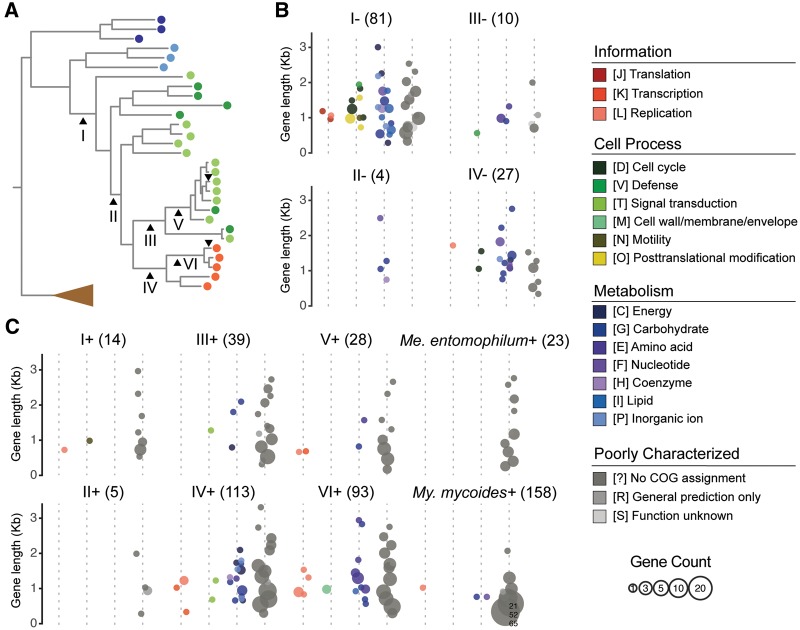
—Characteristics of the genes gained and lost. (A) Phylogenetic positions of the six internal branches and two terminal branches analyzed in this study. The species phylogeny is based on the result from figure 1A. (B) Putative gene losses. The number in parentheses above each subpanel indicates the total number of inferred gene losses. The genes are binned by length using 250-bp intervals and color-coded according to their functional category assignments. The circle size is proportional to the number of genes in each bin. (C) Putative gene gains.